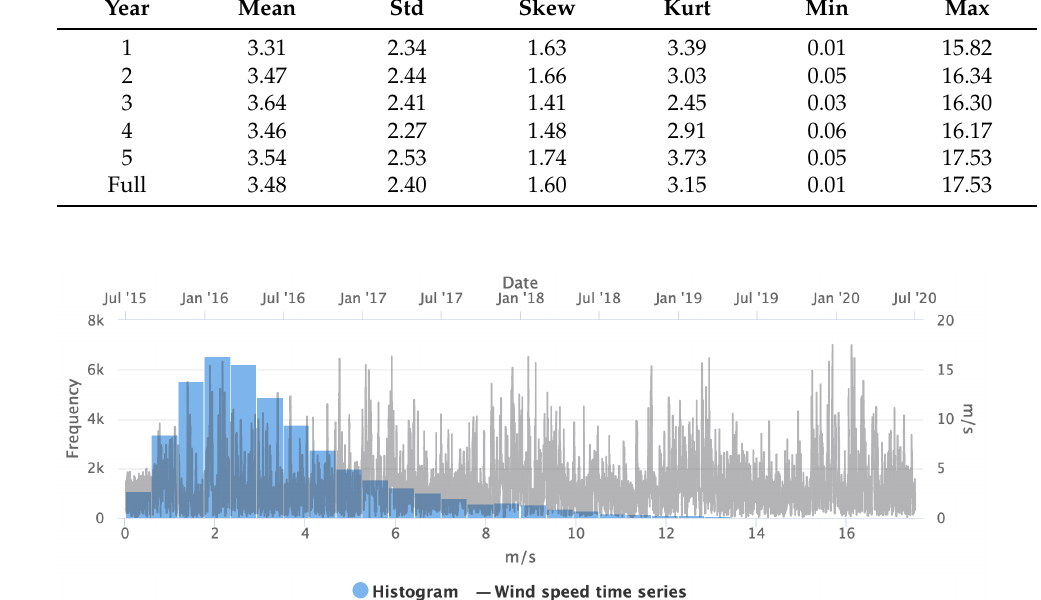
Figure 1. Histogram and time series of wind speed.